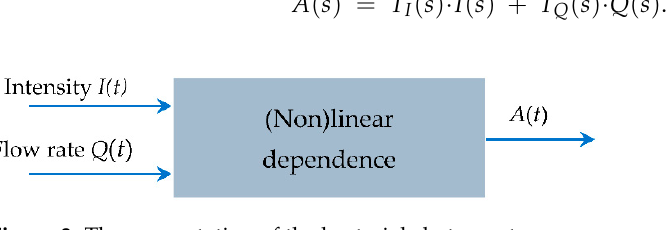
Figure 3. The computation of the bacterial abatement.